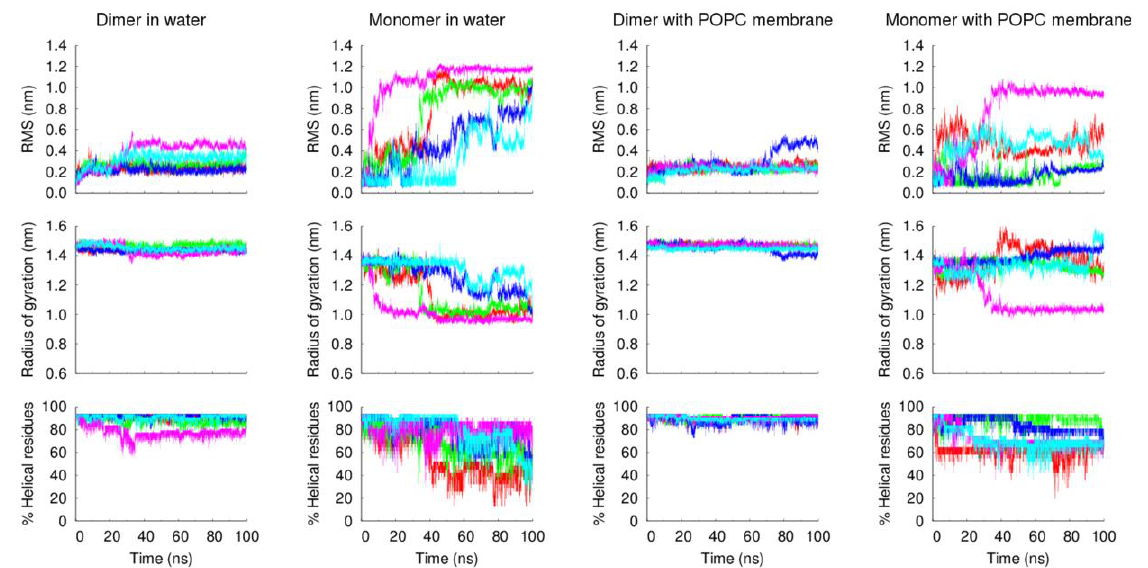
Figure 6. Structural properties of the VIKI-dPEG4-Chol peptide in MD simulations. The temporal evolution of the Cα root mean square deviation (RMSD) from the starting structure, radius of gyration and percentage of α-helical residues (measured by DSSP) is shown for each simulation set. The different lines in each plot correspond to independent replicates: replicates 1 to 5 are colored red, green, blue, magenta and cyan, respectively.